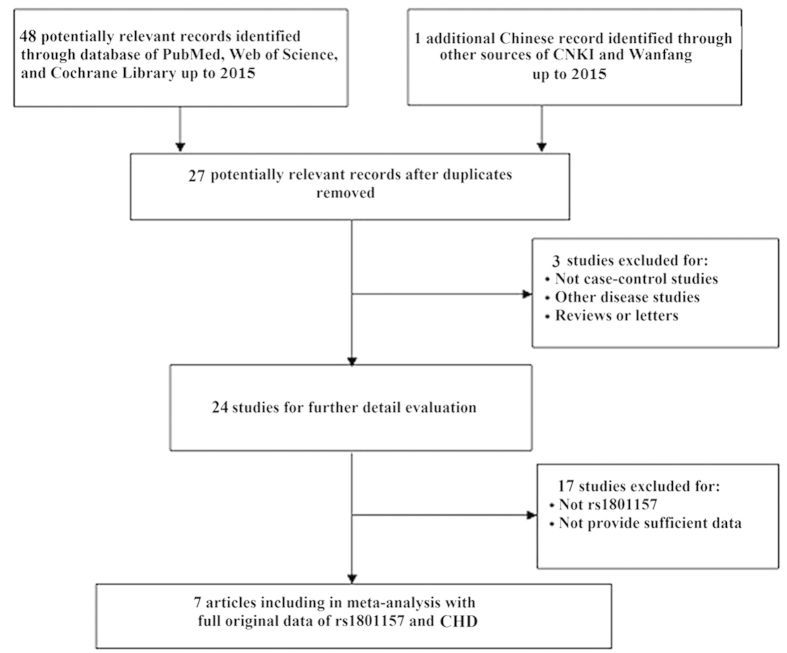
Flow diagram of the study selection process.